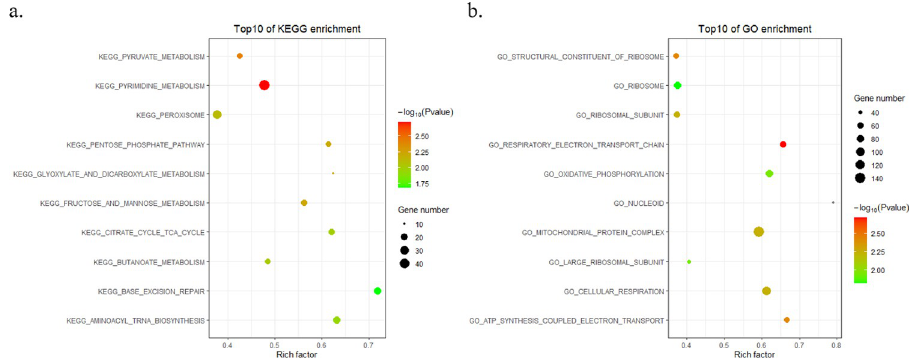
Fig 6. Functional enrichment analysis based on low-risk and high-risk groups. a) Top 10 enrichment pathways in KEGG based on the largest absolute NES. b) Top 10 enriched GO pathways based on the largest absolute NES.